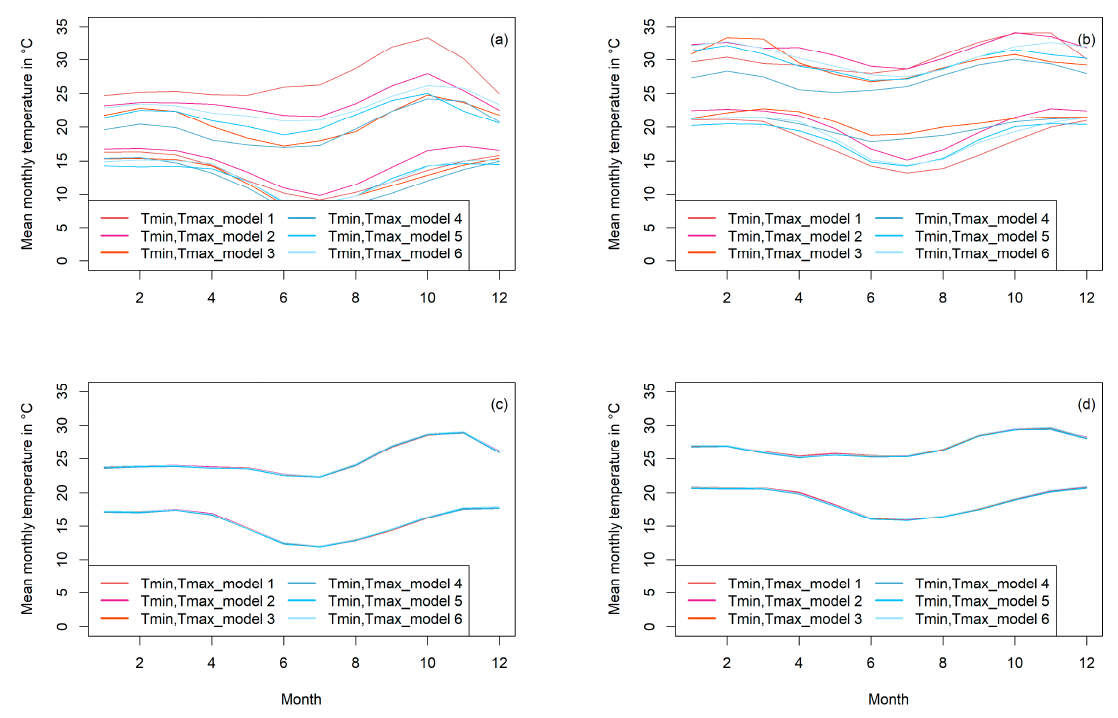
Figure 7. Mean monthly minimum and maximum temperatures from 1979 to 2005 for two exemplary stations out of the 21 utilized CORDEX Africa datagrids before and after bias-correction. ( a , b ) Temperatures before bias correction. ( c , d ) The same stations after bias-correction. Each graph shows the average Tmin and Tmax monthly temperature for all six models introduced in Table 2. ( c , d ) The last plotted lines from model 6 superimposed over the other models’ lines due to their similarity after bias correction. All 21 stations can be found in the appendix before (Figure A1) and after bias-correction (Figure A2). Table 3. Historical monthly average minimum (Tmin) and maximum temperature (Tmax) according to the bias-corrected RCM simulations (1979–2005). The given values represent the average of the monthly average Tmin and Tmax of all 21 utilized CORDEX Africa grids, respectively.